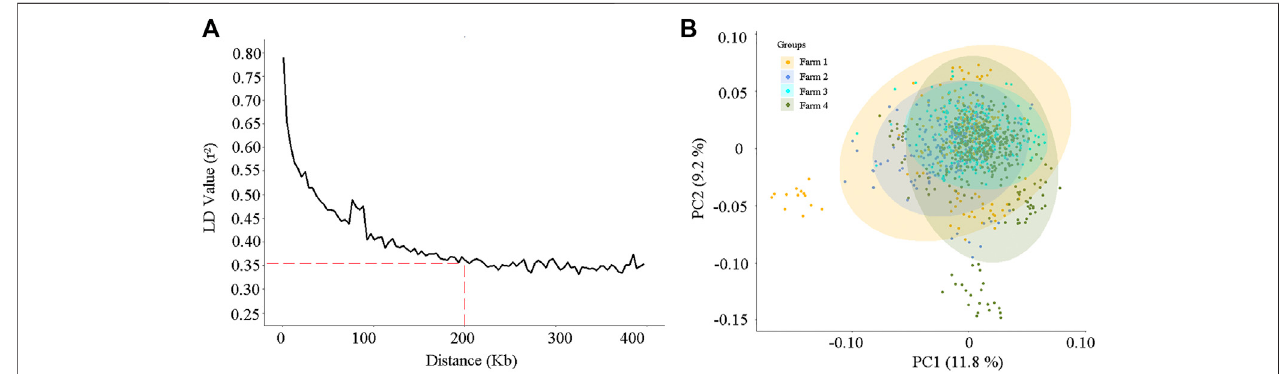
FIGURE 3 | The linkage disequilibrium decay analysis (A) and the principal component analysis (B) according to the 84,407 single nucleotide polymorphisms (SNPs) for the 984